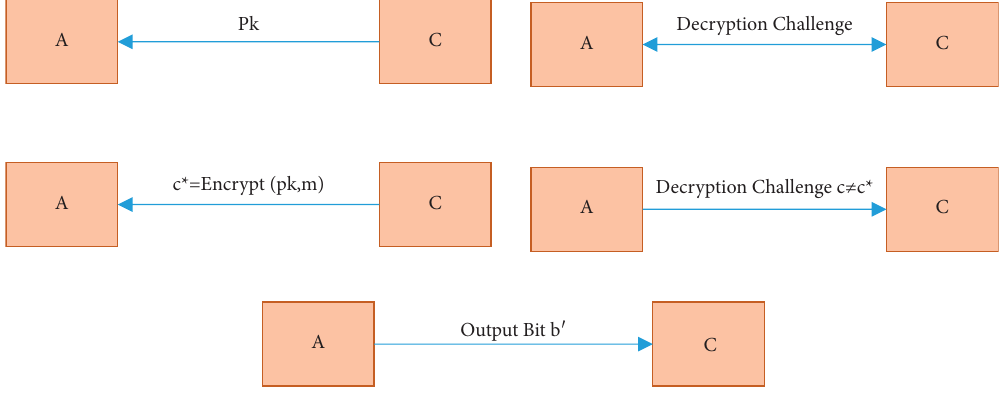
Figure 2: CCA2 security game of PKE system.